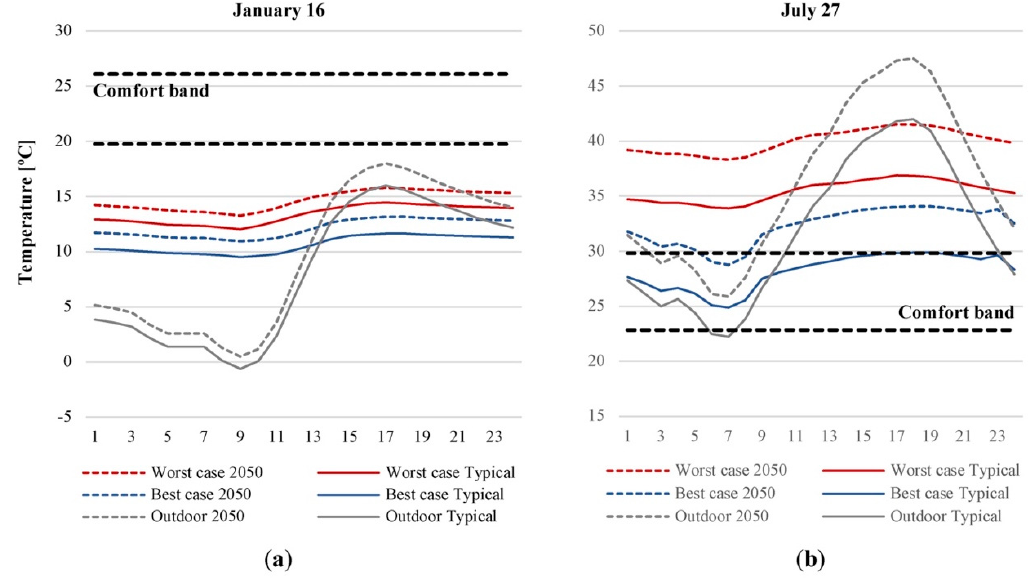
Figure 9. Hourly evolution of the indoor and outdoor air temperature, under typical climatic conditions and the 2050 climate scenario: ( a ) for a typical winter day; ( b ) for a typical summer day.